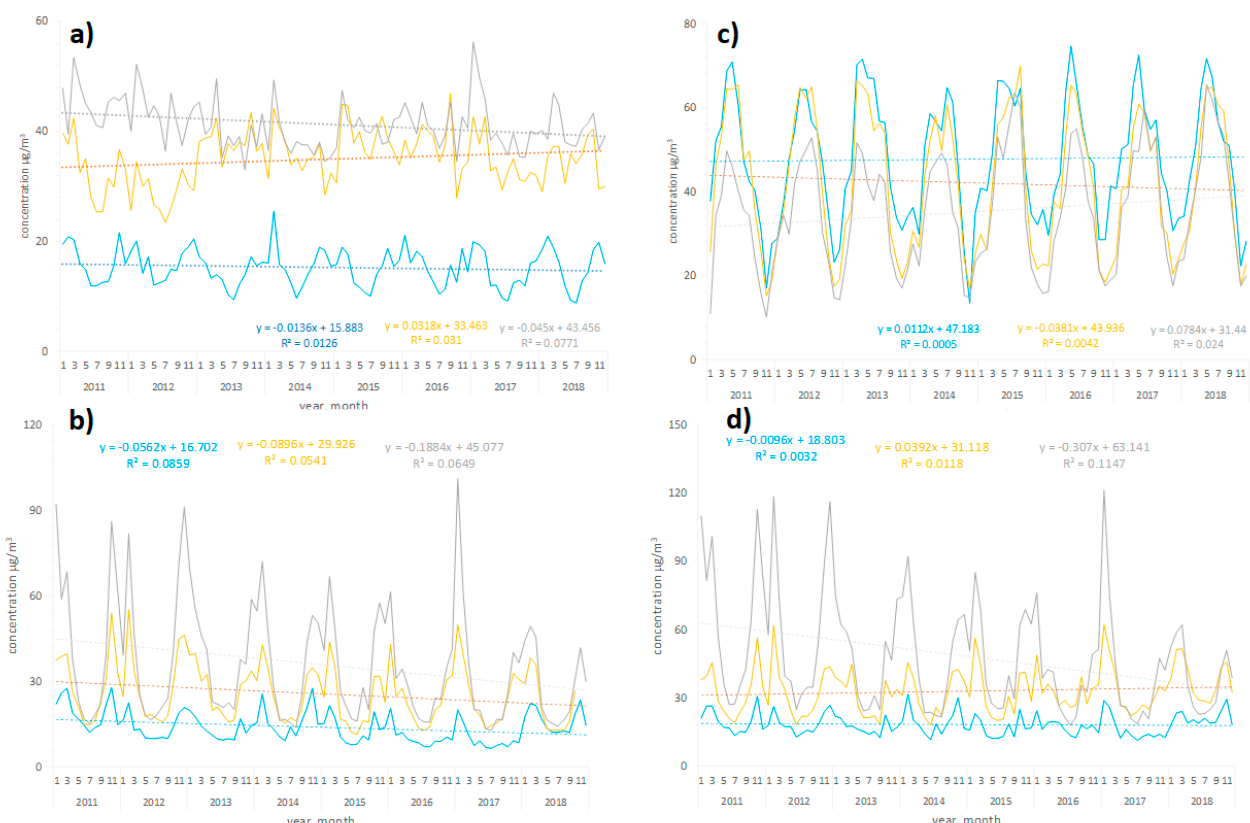
Figure 2. Daily concentration levels of air pollutants: ( a ) nitrogen dioxide (NO 2 ); ( b ) ozone (O 3 ); ( c ) particulate matter PM 2.5 ; ( d ) particulate matter PM 10 in analyzed agglomerations: Warsaw (in yellow); Cracow (in grey); Tricity (in blue), from 2011 to 2018. Linear regression curves are shown as dotted lines. Corresponding equations were also indicated.